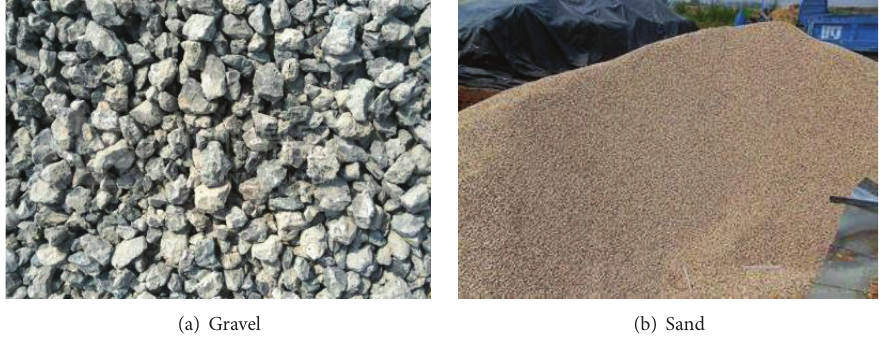
Figure 2: Basalt gravel and river sand.